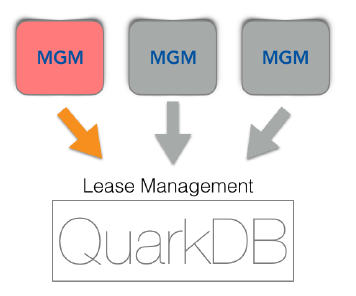
Figure 3. Lease mechanism using